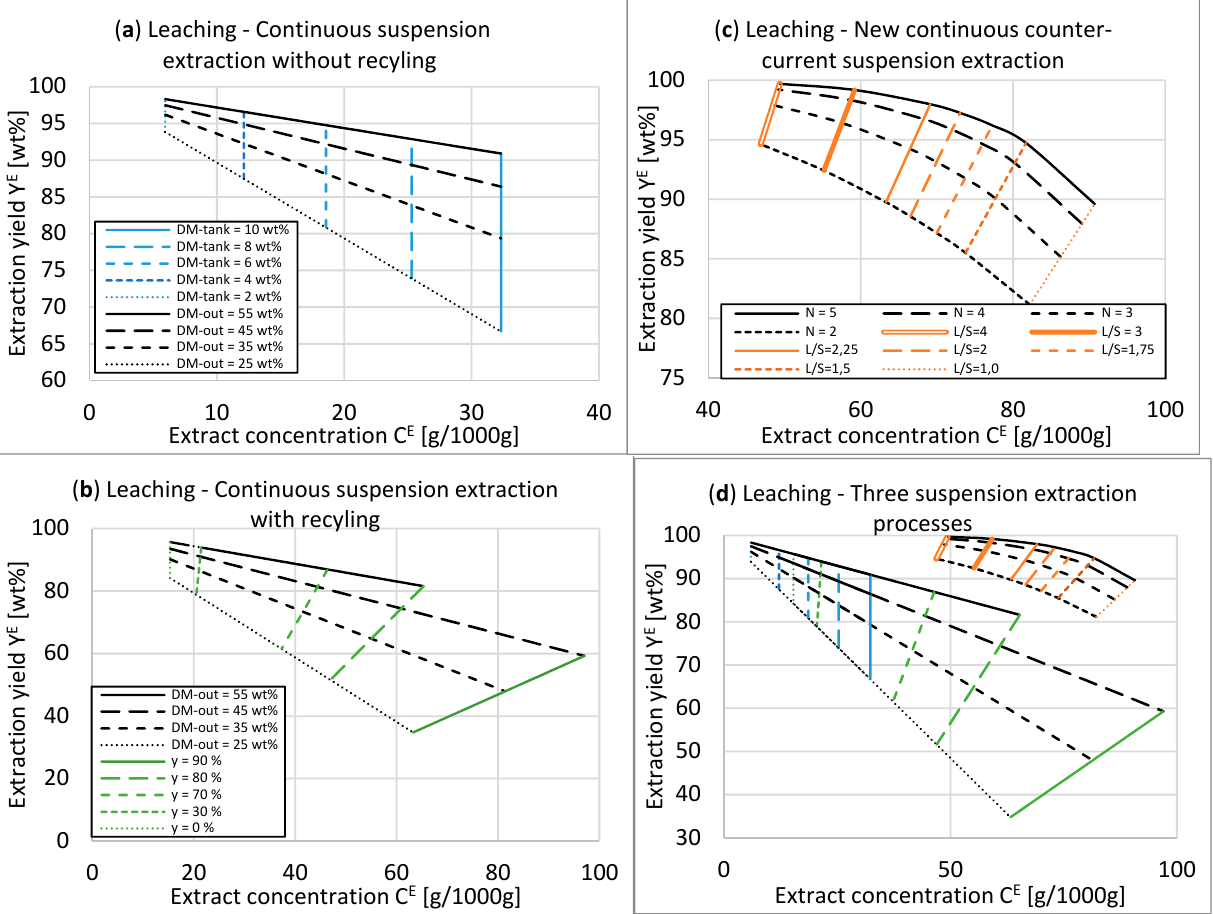
Figure 4. Process windows for the continuous suspension extraction processes for the leaching scenario. ( a ) Continuous suspension extraction without recycling. ( b ) Continuous suspension extraction with recycling. ( c ) New continuous counter-current suspension extraction. ( d ) All three suspension extraction processes. DM-tank = dry matter content in the extraction tank. DM-out = dry matter content at the stage outlet (press). y = recycling factor. N = number of stages. L/S = liquid to solid ratio (solvent consumption).